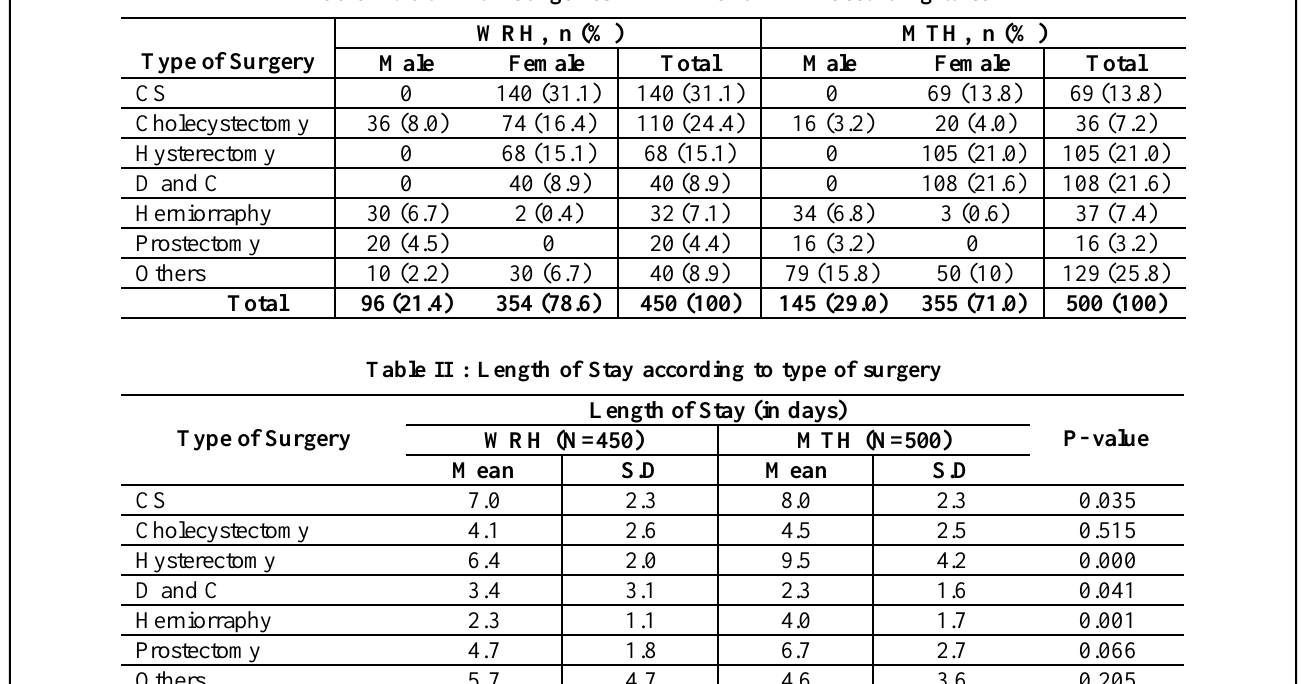
Table I : Common Surgeries in WRH and MTH according to sex